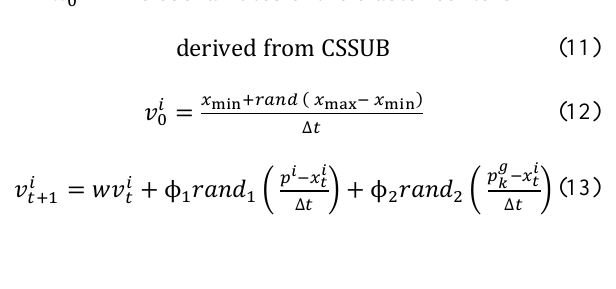
Fig. 3. PSO algorithm